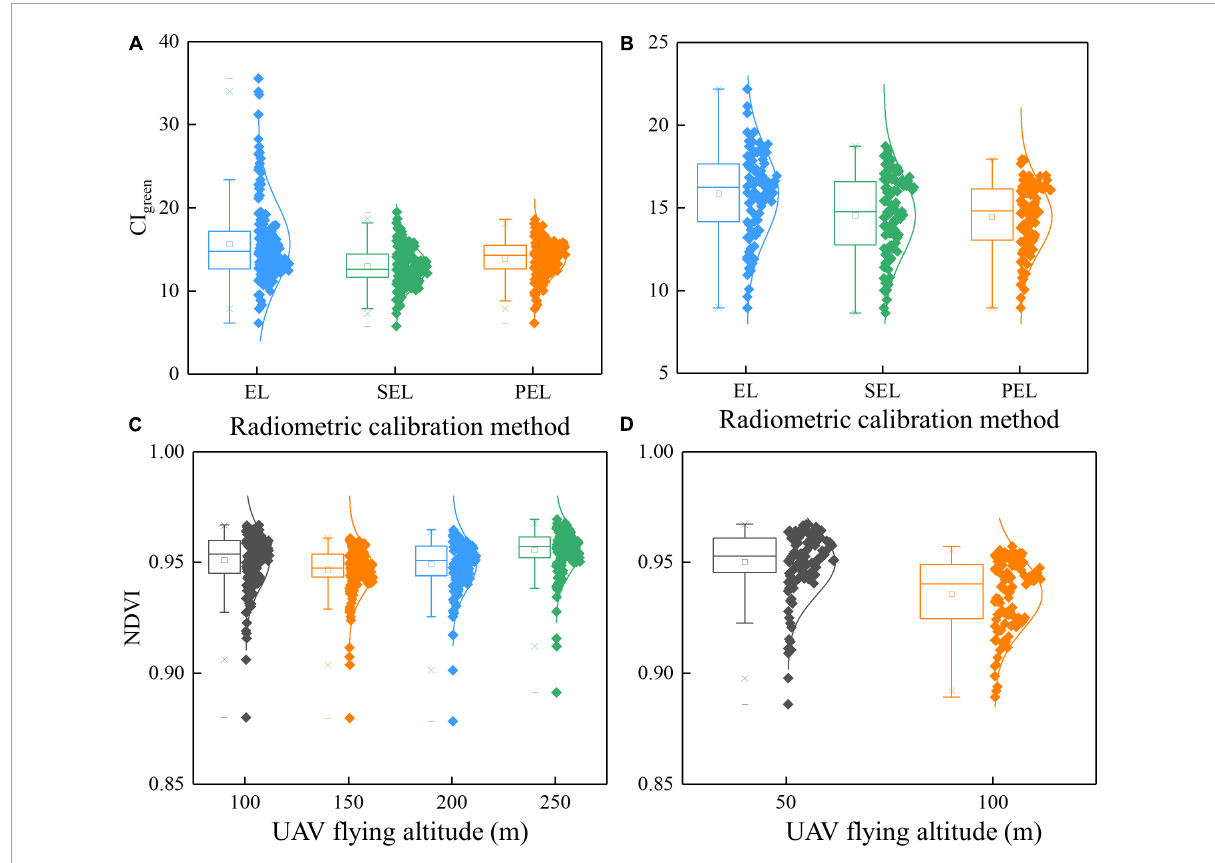
FIGURE8 Boxplot for the comparison of VIs based on different RCMs and UAV-FAs: (A) CI green based on different RCMs in Test 1; (B) CI green based on different RCMs in Test 2; (C) NDVI based on different UAV-FAs in Test 1; (D) NDVI based on different UAV-FAs in Test 2.